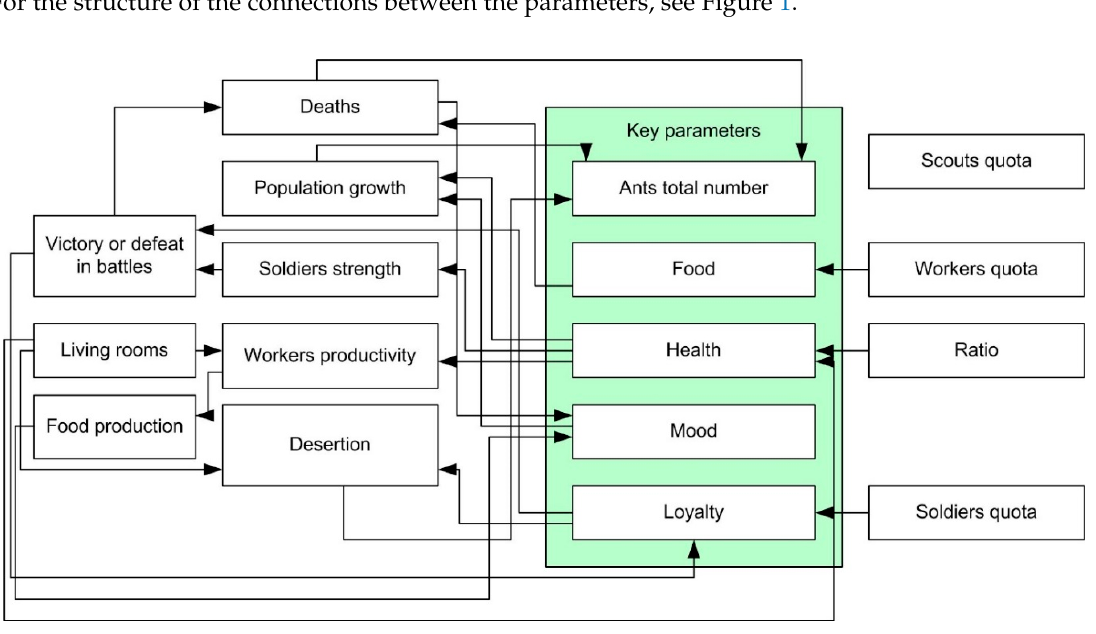
Figure 1. The structure of variables relationships in “The Anthill” complex problem.